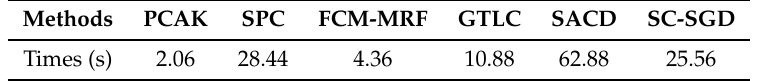
Table 1. Classification accuracy (%) obtained by an ensemble of 200 discrimination